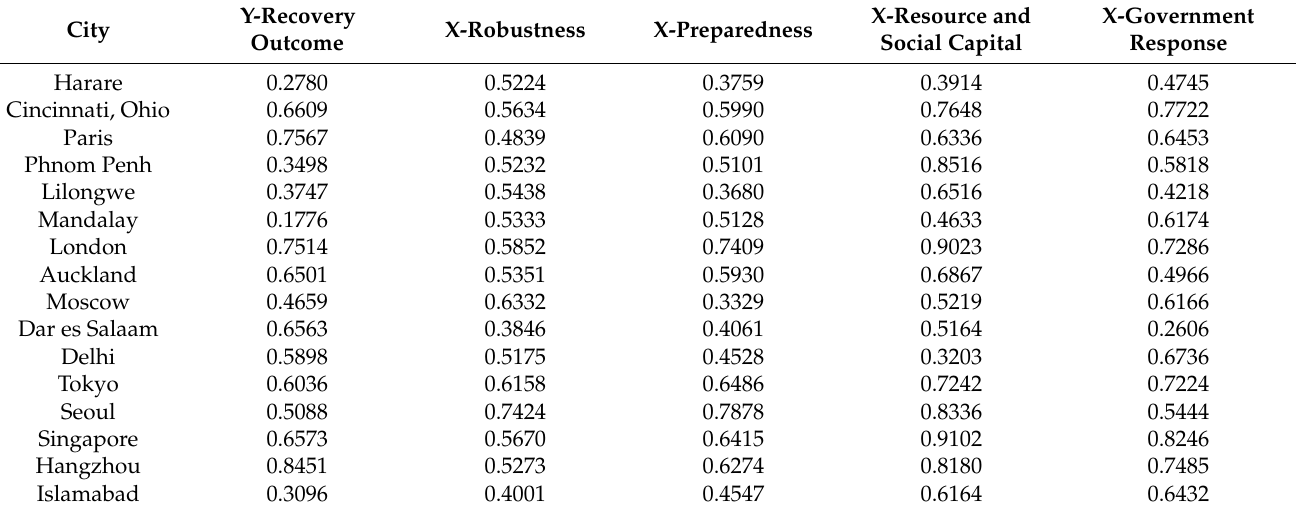
Table 5. Averaged indexes of contributing